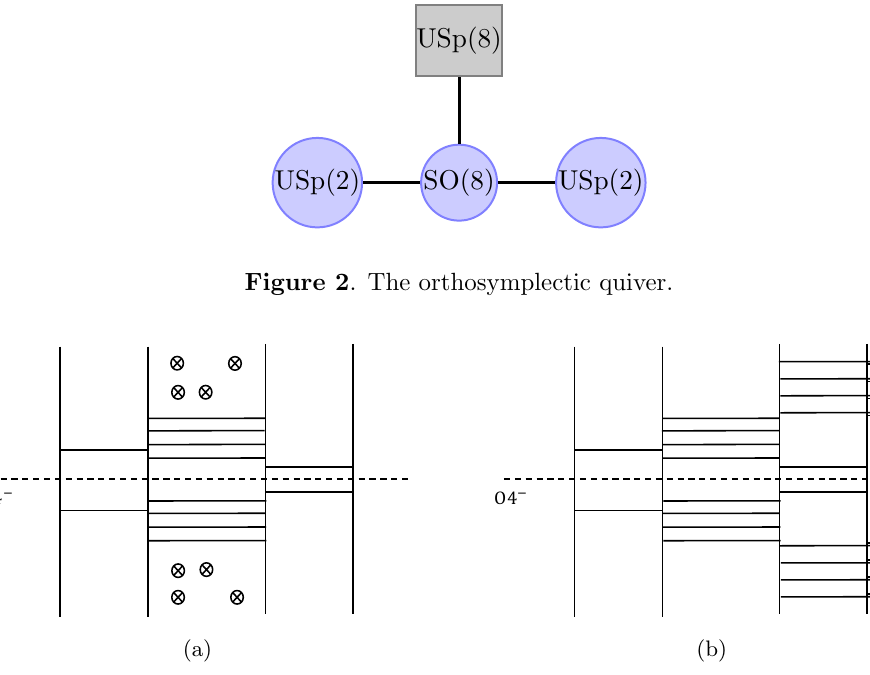
Figure 3 . Brane picture realizing the orthosymplectic quiver of (cid:12)gure